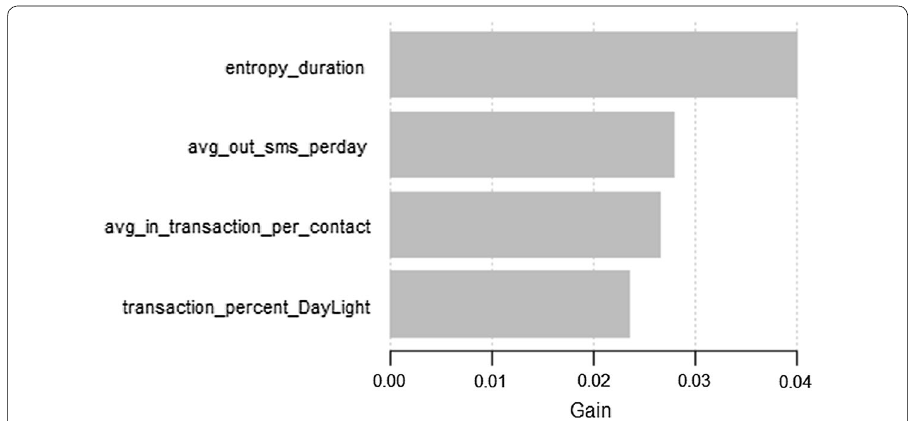
Fig. 8 Top 4 predicted features for